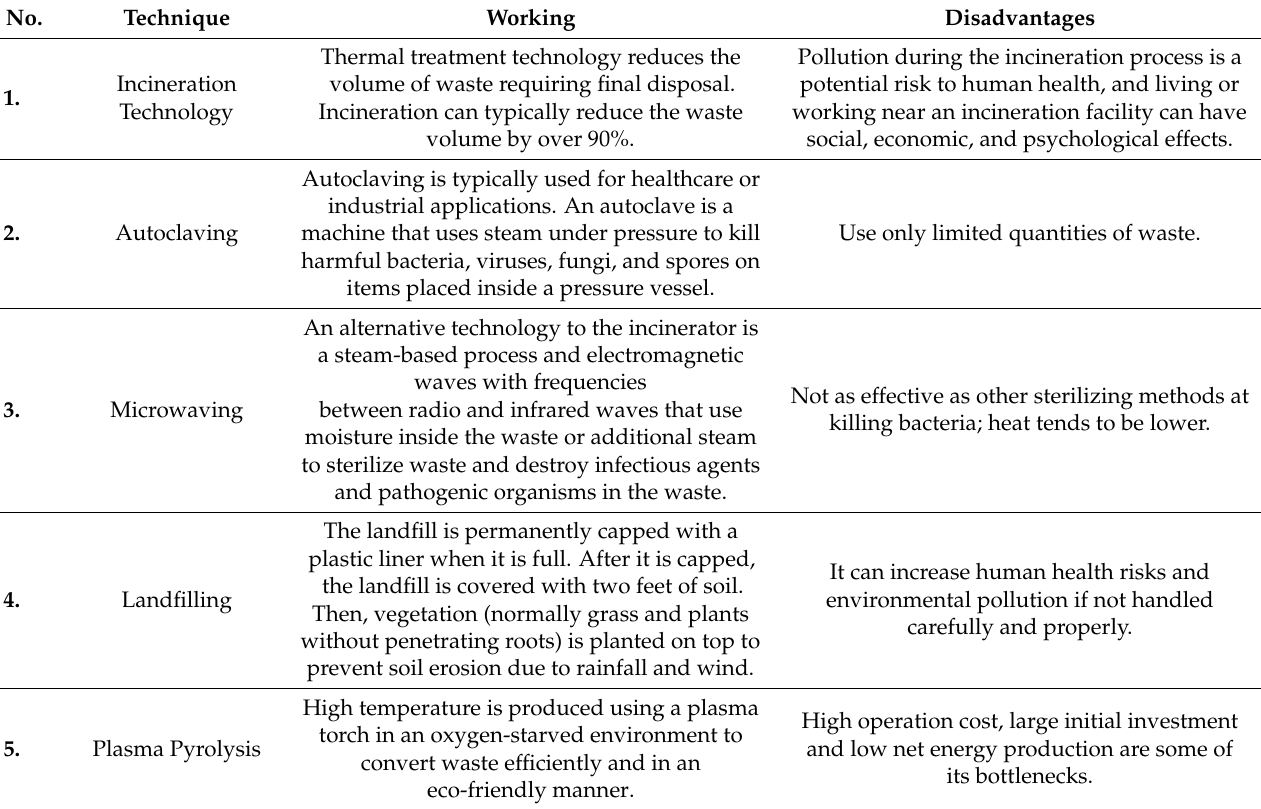
Table 1. Comparison of various human waste management